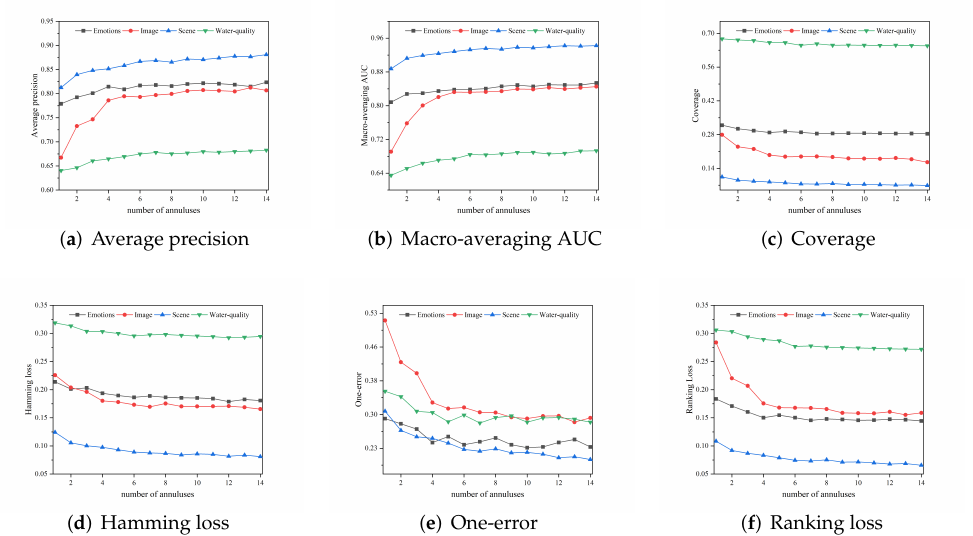
Figure 5. Performance of DEPT changes in terms of each evaluation metric as the parameter r increases from 1 to 14 on four regular-scale data